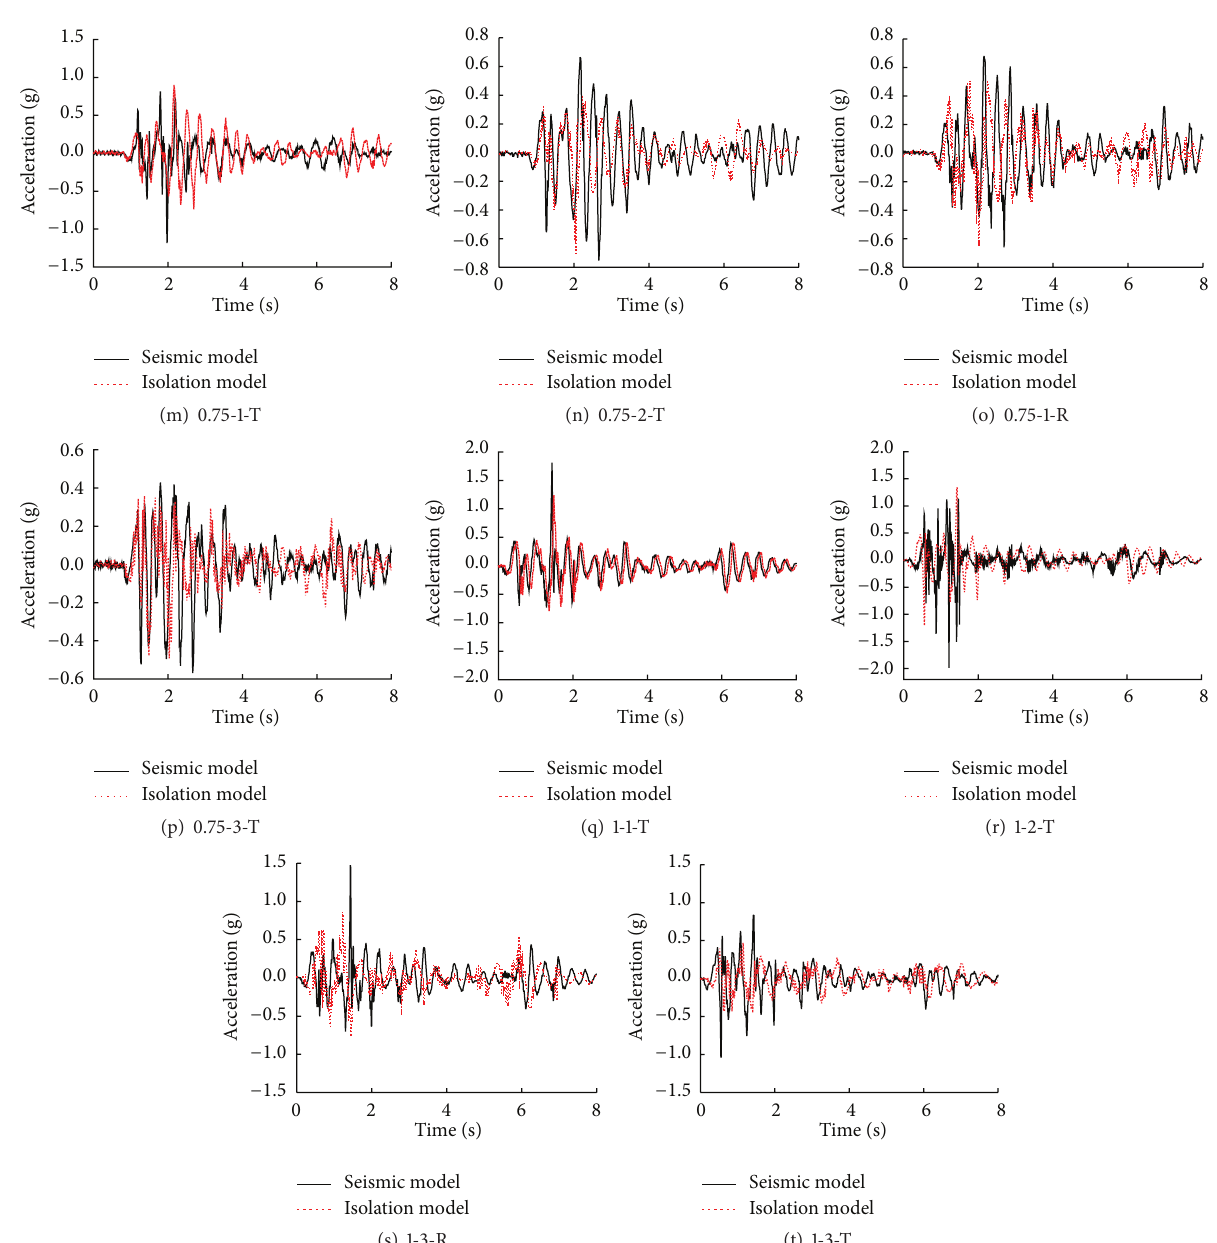
Figure 8: Comparison of time history curves of acceleration. Note: 0.25-1-R stands for the radial acceleration time history curves of the top of pier #1 when the input peak acceleration of seismic wave was 0.25 g PGA; 0.25-1-T stands for the tangential acceleration time history curves of the top of pier #1 when the input peak acceleration of seismic wave was 0.25 g PGA and similar to other circumstances.